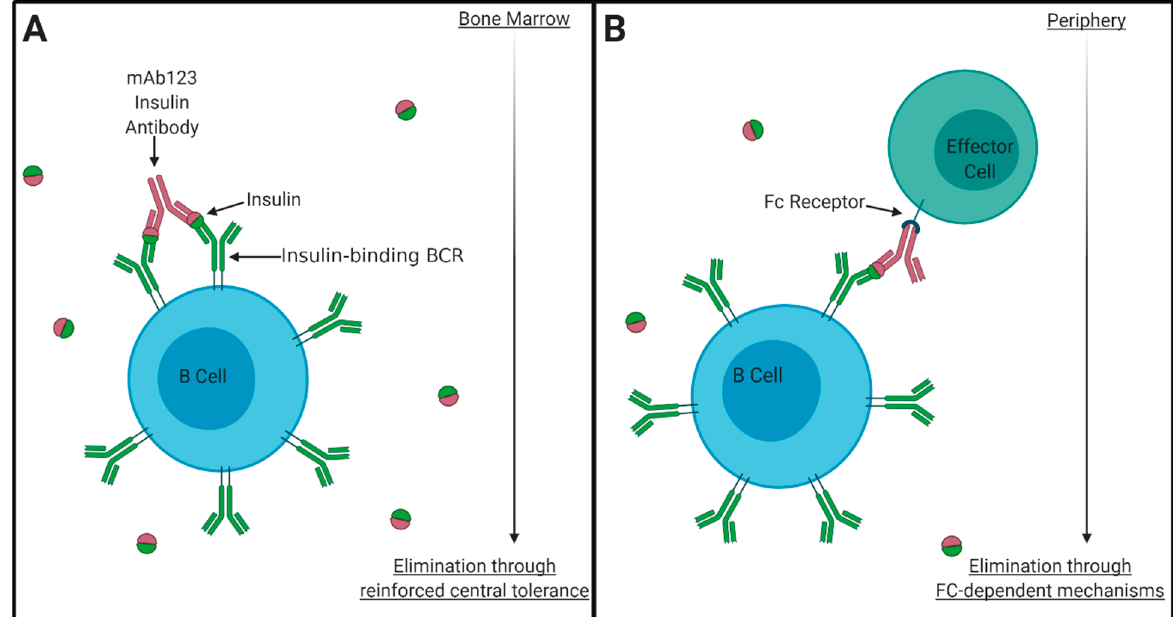
Figure 2. Fighting fire with fire: using anti-insulin mAbs to target AIBCs. Insulin-occupied BCRs are found on the surface of mouse B cells that express transgenic anti-insulin BCRs. This can be exploited by using an anti-insulin antibody (mAb123) that binds a separate epitope of the BCR to selectively eliminate AIBCs from the repertoire and prevent T1D in NOD mice [47]. Two mechanisms have been shown to drive this depletion. ( A ) Enhanced BCR crosslinking reinforces central tolerance in the bone marrow. This Fc-independent function improves receptor editing to limit AIBC escape into the periphery [81]. ( B ) Fc recognition provokes AIBC elimination, presumably via antibody-dependent cell-mediated cytotoxicity, a mechanism of action for other antibody-based biologic therapies. Original image, created with BioRen- der.com.